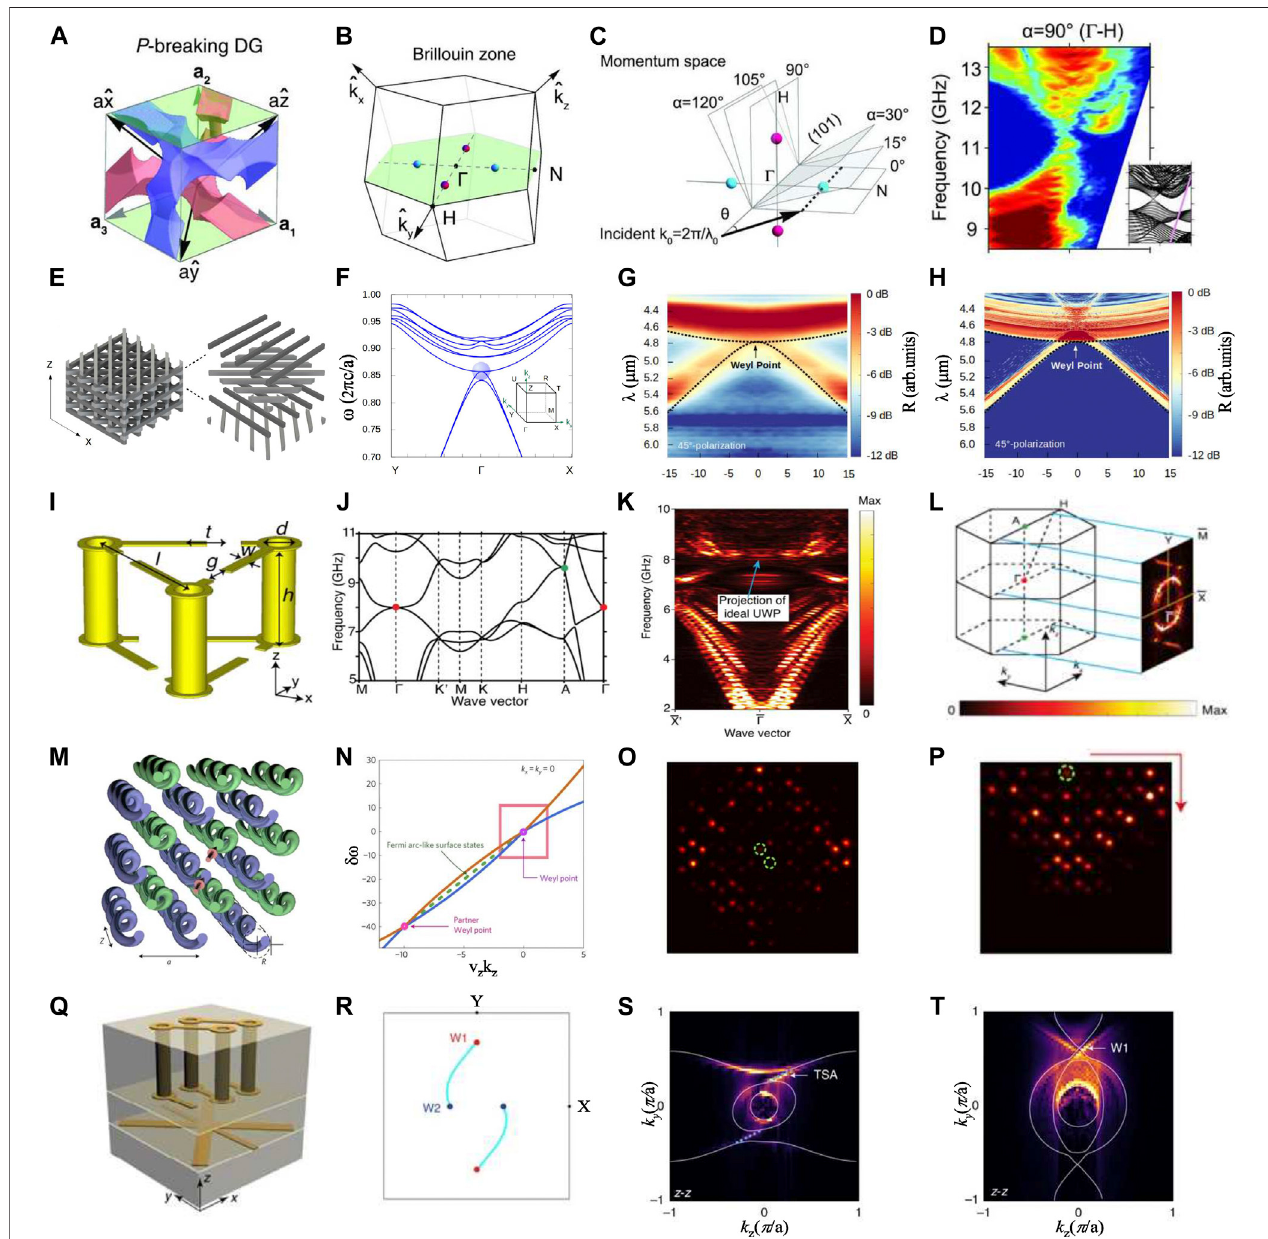
FIGURE3|(A) bcccellofthe P -breakingdoublegyroidphotoniccrystal[54]. (B) TwopairsofWeylpointsareillustratedonthegreen(101)planealong Γ - H and Γ - N in the Brillouin zone. (C) The different bulk states can be excited by changing the incidence angle θ of the incident wave. (D) Experimental results of the Weyl point along the Γ - H direction. (E) Schematicdiagramofthechiralwoodpilestructure[58]. (F) Thebandstructurealongthe Y- Γ - X andtheWeylpointisillustratedwithabluecircle. (G) and (H) experimentally measured and simulated re fl ection spectra showing Weyl point for 45 ° polarizations, respectively. (I) The unit cell of the chiral metamaterial [63]. (J) Weylpointsaredenotedbyredandgreendotsinthebandstructure. (K) Measuredprojectedbanddiagramonthe k x – k z plane. (L) Measuredsurfacedispersion obtained by Fourier transformation. (M) Schematic diagram of the waveguide array structure [64]. (N) The dispersion diagram in the δ k x – δ k z plane when δ k x (cid:1) δ k y (cid:1) 0 showsthetype-IIWeylpointsand Fermiarc – likesurfacestates. (O) Experimental resultsoftheintensityplotsattheoutputfacetat a (cid:1) 27 μ m, λ (cid:1) 1,525 nm,andconical diffractiondemonstratestheexistenceoftype-IIWeylpoints.Greencircles:positionofinputwaveguides. (P) Experimentalresultsoftheintensityplotsattheoutputfacet at a (cid:1) 27 μ m, λ (cid:1) 1,500 nmdemonstratethepresenceofFermiarc – likesurfacestates.Greencircles:positionofinputwaveguides. (Q) Schematicdiagramoftheunitcell ofchiralhyperbolicmetamaterials[71]. (R) Surfacebandstructureonavaryingfrequency k x – k y map. (S) and (T) Experimentalresultsofthetopologicalsurface-statearcs and type-II Weyl points in the momentum space at 5.46 GHz,